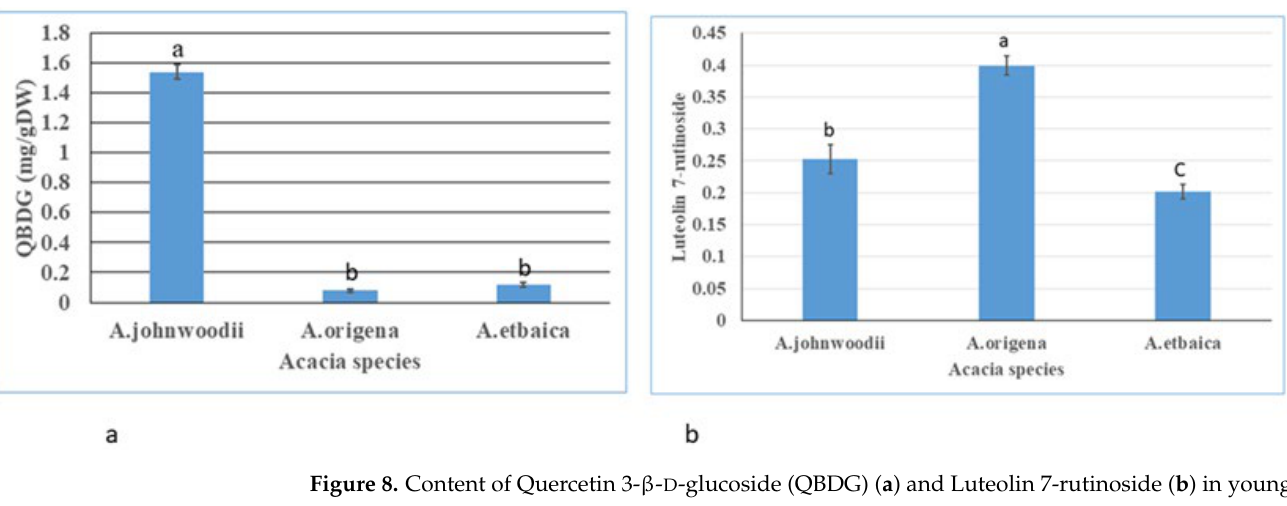
Figure 8. Content of Quercetin 3- β - D -glucoside (QBDG) ( a ) and Luteolin 7-rutinoside ( b ) in young leaves of Acacia species estimated by HPLC system. Values are the mean of three replicates ± S.D. Letters on bars represent the significant differences according to Duncan’s test ( p < 0.05).